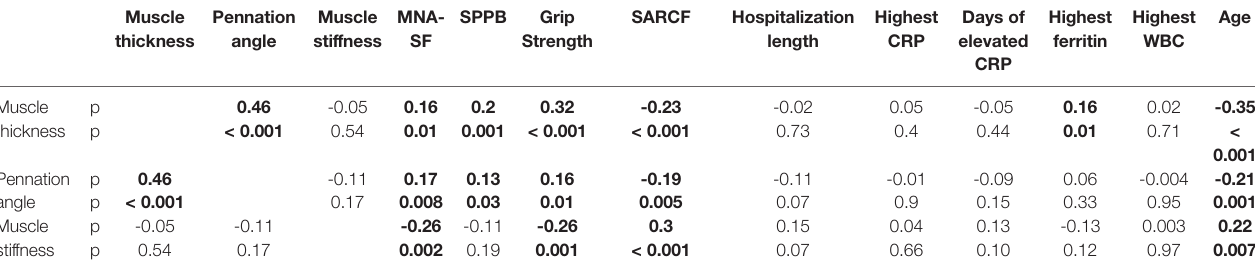
TABLE 4 | Spearman correlations among muscle ultrasound characteristics, measures of muscle function and nutritional status, age, in fl ammatory indexes and length of hospital stay. Muscle Pennation thickness